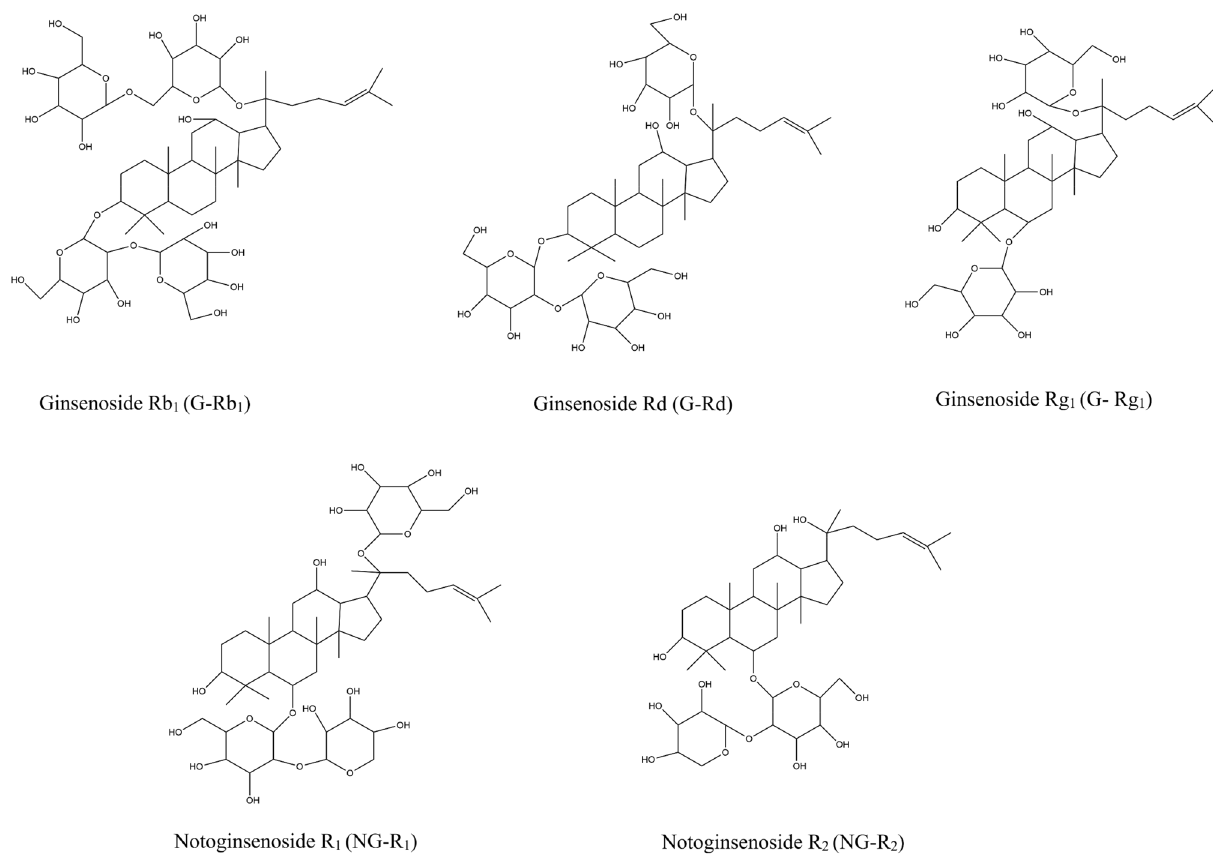
Figure 1. Chemical structures of five reference standards.